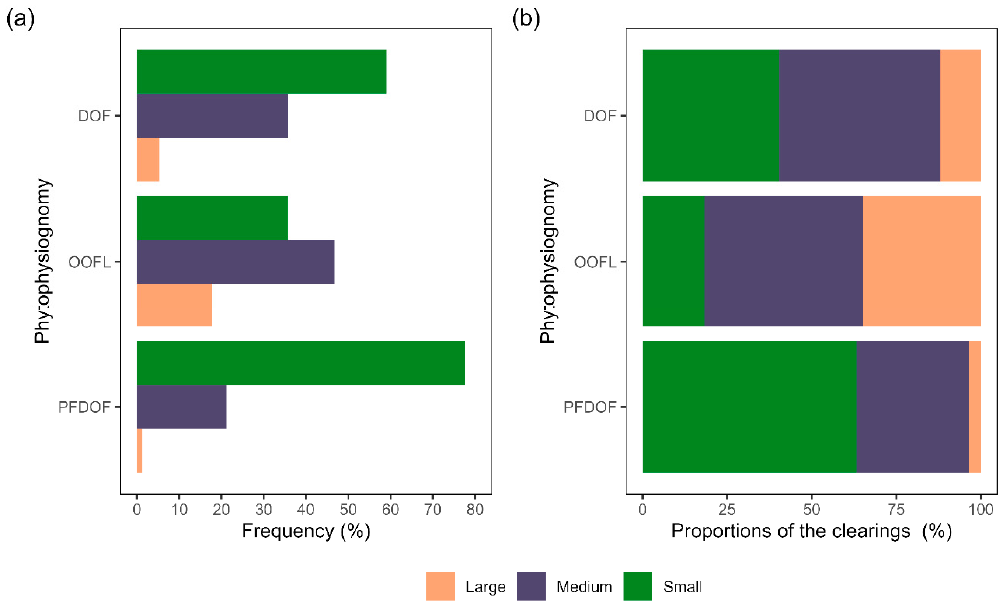
Figure 3. Frequency ( a ) and proportions ( b ) of the gaps caused by the felling of the trees by directional cutting of reduced impact on the studied phytophysiognomies. The highest frequencies ( a ) and proportions ( b ) of large gaps are found in the OOFL phytophysiognomy, and of small gaps in PFDOF. PFDOF: periodically flooded dense ombrophilous forest; DOF: dense ombrophilous forest; OOFL: open ombrophilous forest with lianas. Small: clearing < 100 m 2 ; medium: 100 m 2 ≤ clearing < 200 m 2 ; large: clearing ≥ 200 m 2 .